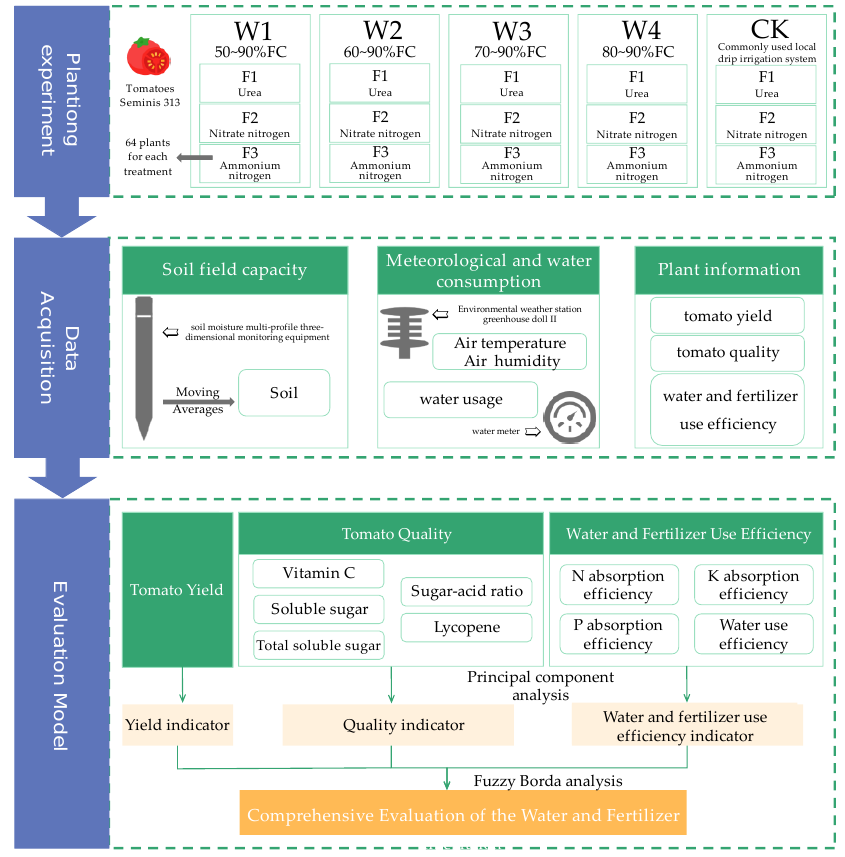
Figure 3. Experimental design.